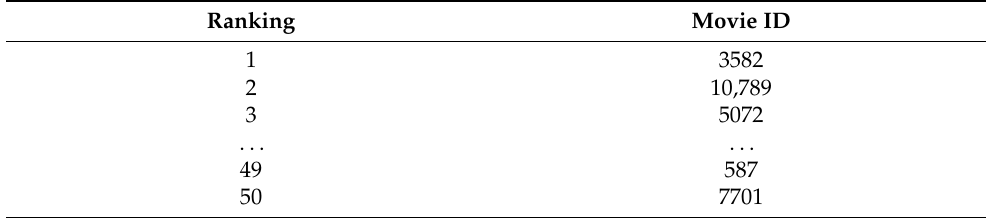
Table 4. Top 50 recommended movies for User ID 6. Ranking Movie